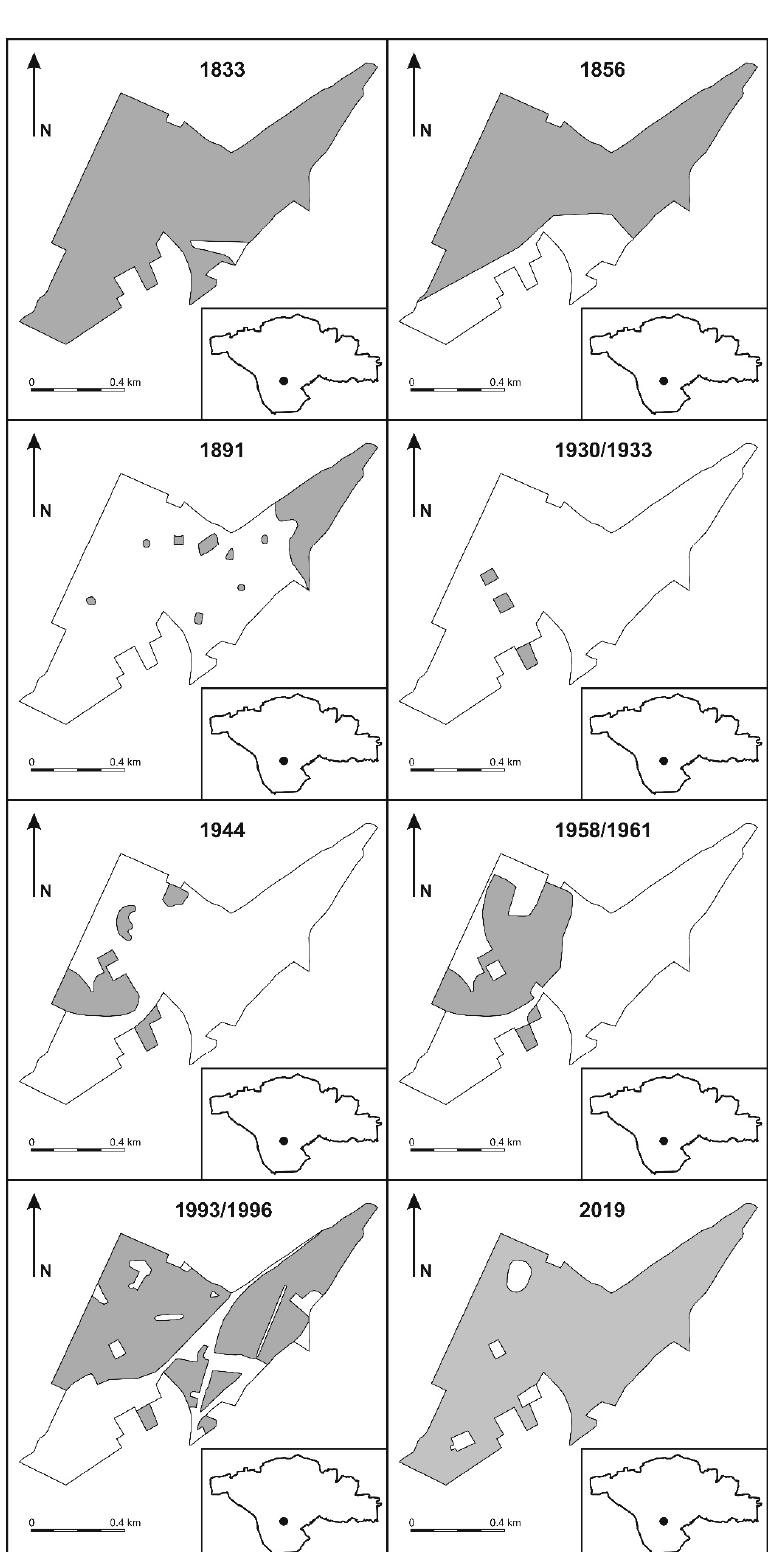
Figure 2. Changes in forested area, 1833–2019. Source: by authors based on historical maps [50–55,58] and contemporary field research in 2019.